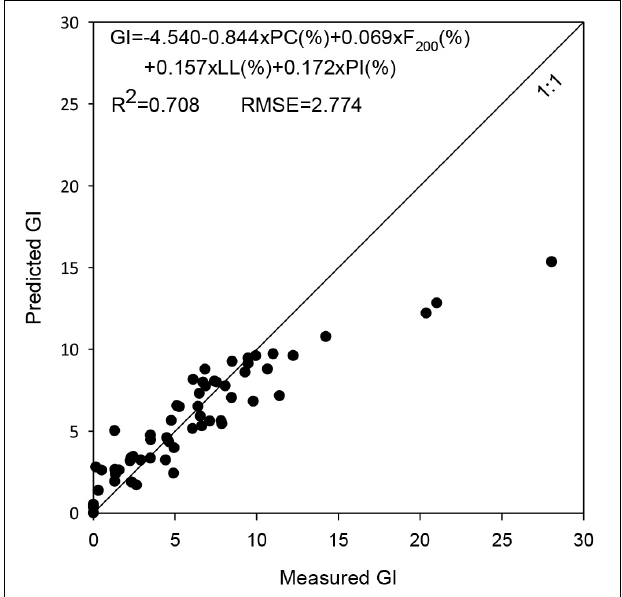
FIGURE 6 | Comparison of measured group index and predicted group index.